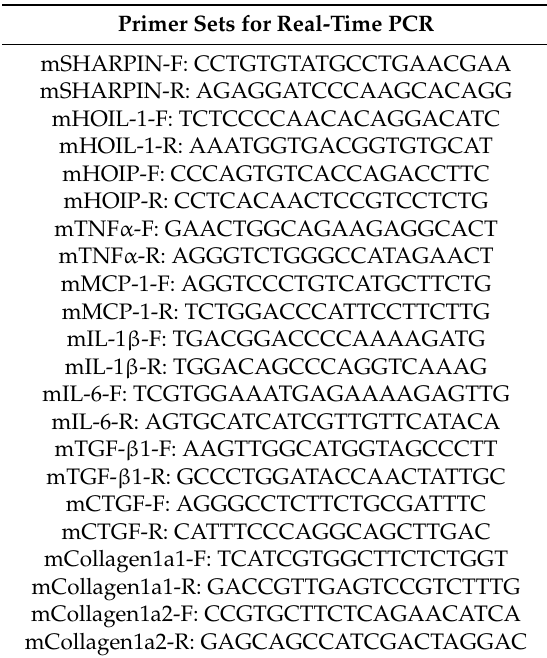
Table 1. Primer sets for real-time